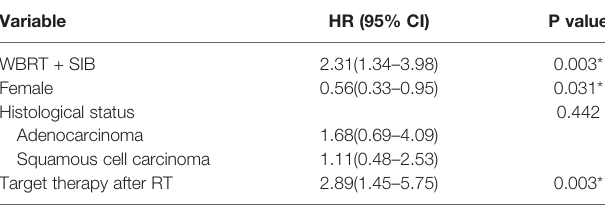
TABLE 5 | Survival-related factors on intracranial PFS in multivariate analysis.